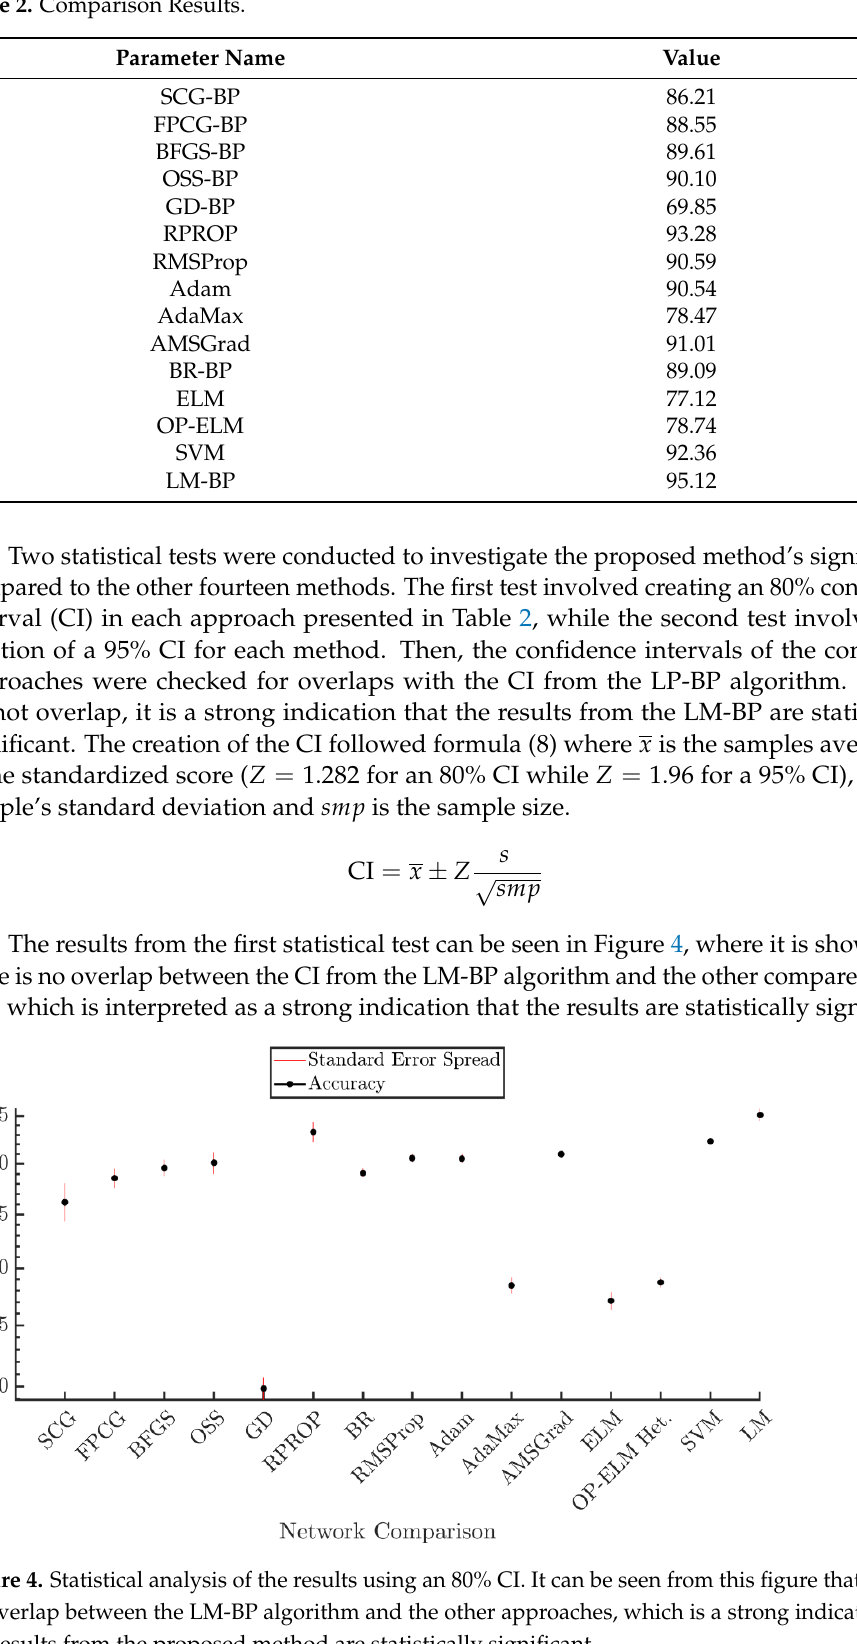
Figure 5. Statistical analysis of the results using a 95% CI. It can be seen from this figure that there is no overlap between the LM ‐ BP algorithm and the other approaches, which is a strong indication that the results from the proposed method are statistically significant. One exception is the RPROP method, which overlaps with the LM ‐ BP algorithm, which doesn’t allow any conclusion regarding the statistical significance between the two methods. 6. Discussion This article presents a system for automatically classifying the hemiplegia type be ‐ tween patients and healthy individuals. The system receives data from RehaGait’s mobile gait analysis system accelerometer, which underwent a pre ‐ processing and feature extrac ‐ tion procedure. Then, the extracted features create the input vector to an LM ‐ BP ‐ based classification algorithm, classifying them into three classes (healthy, left, or right hemiple ‐ gia). The experimental results from comparing the LM ‐ BP ‐ based method with fourteen different machine learning methods experimentally verified the proposed method’s ad ‐ vantage over existing ones in terms of classification accuracy. The proposed method was run one additional time. The results from this run were used to create the confusion matrix shown in Figure 6.